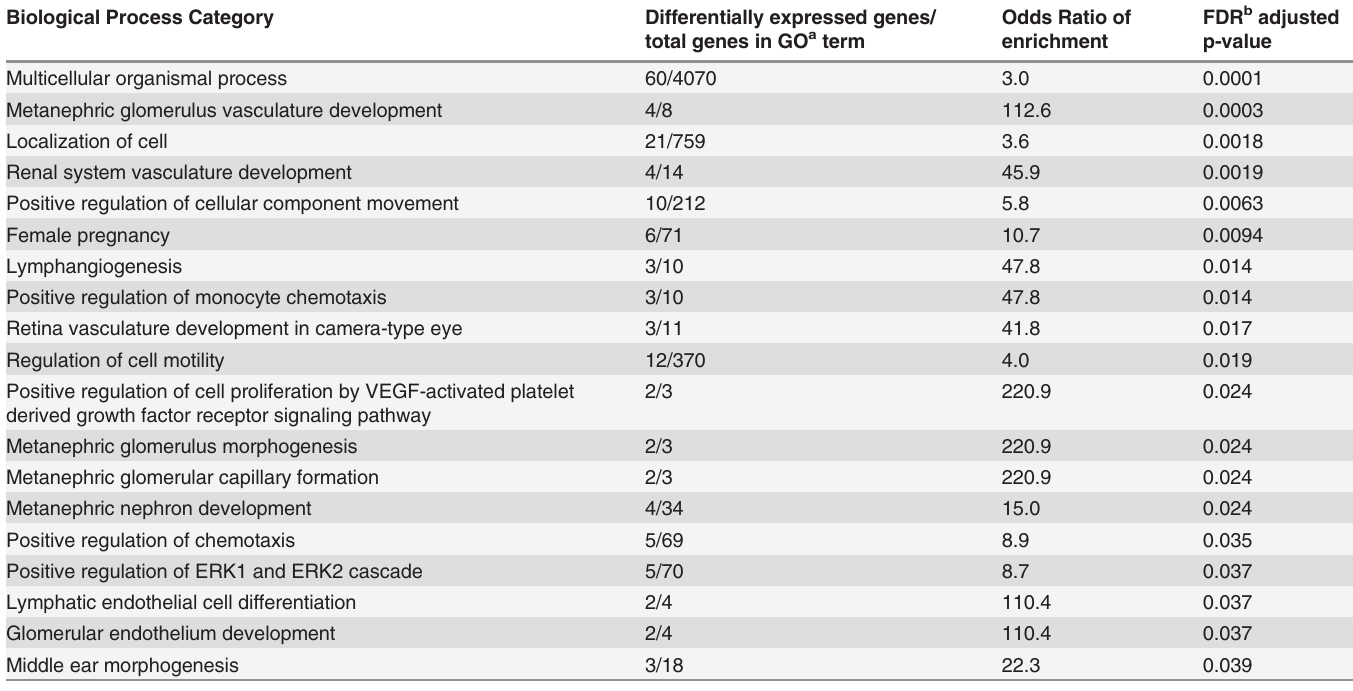
Table 5. Biological processes enriched for genes differentially expressed between the neurocognitive impairment and no impairment groups. Biological Process Category